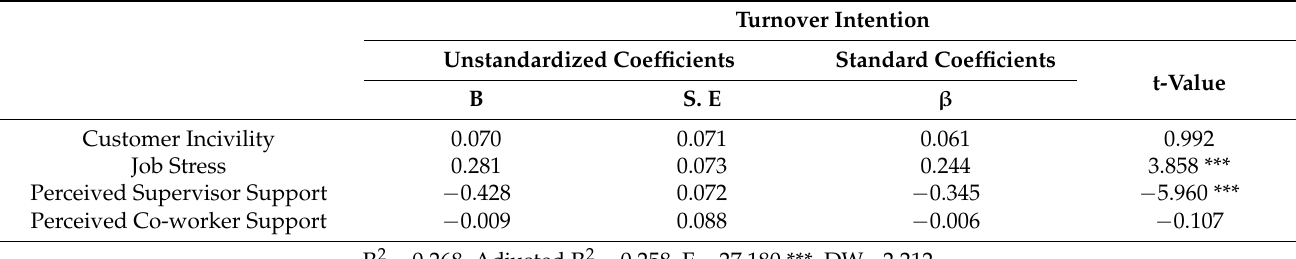
Table 4. Results of regression